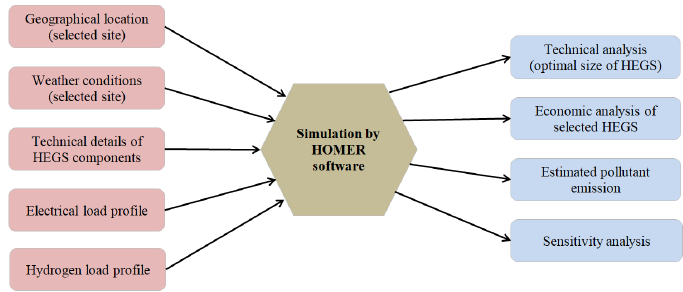
Figure 11. Block diagram process of HOMER software.